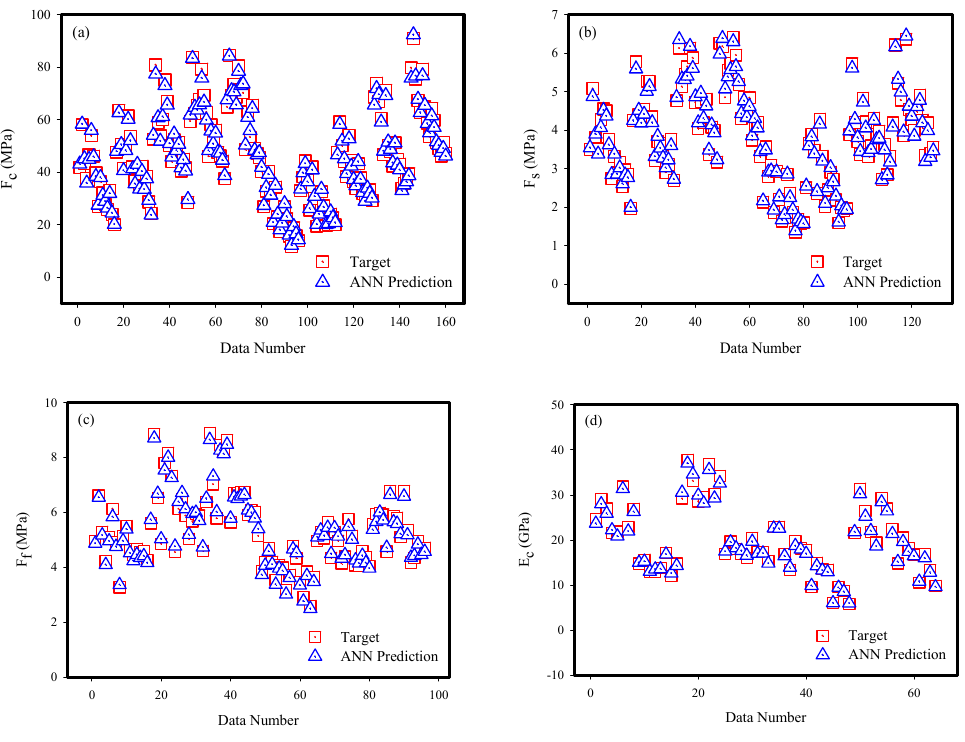
values. The data points reflecting the MoD values are placed near to the zero line error, when the figures presented for every of the Fc, Fs, Ff and Ec values are examined. The numbers, however, make it very evident that the MoD levels are quite low. The predicted mean MoD values for the Fc, Fs, Ff and Ec values were − 0.28%, 0.14%, 0.87% and 1.17%, respectively.